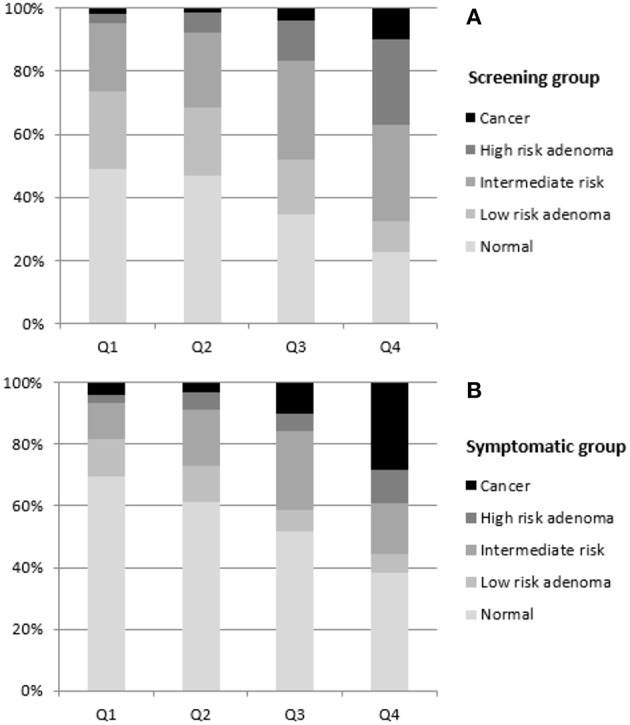
Colonoscopy findings according to Hb quartile in (A) screening group (p < 0.001) and in (B) symptomatic group (p < 0.001).